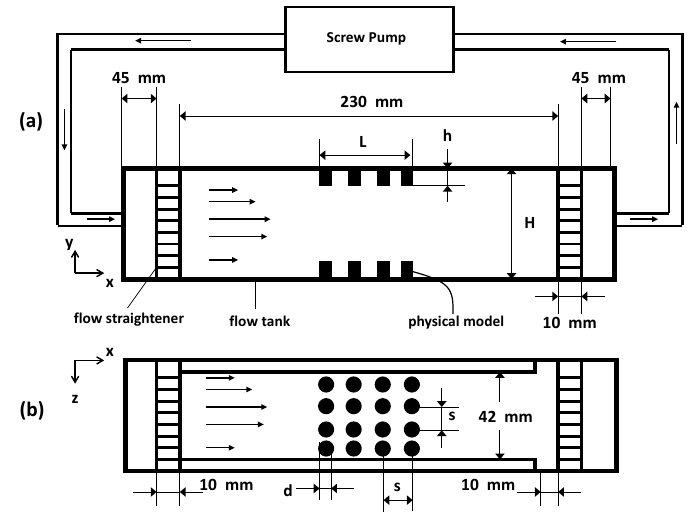
Figure 3. Schematic of the experimental setup showing the side view ( a ) and the top view ( b ) of the flow chamber with the physical model inserted. Flow direction in the tank is from right to